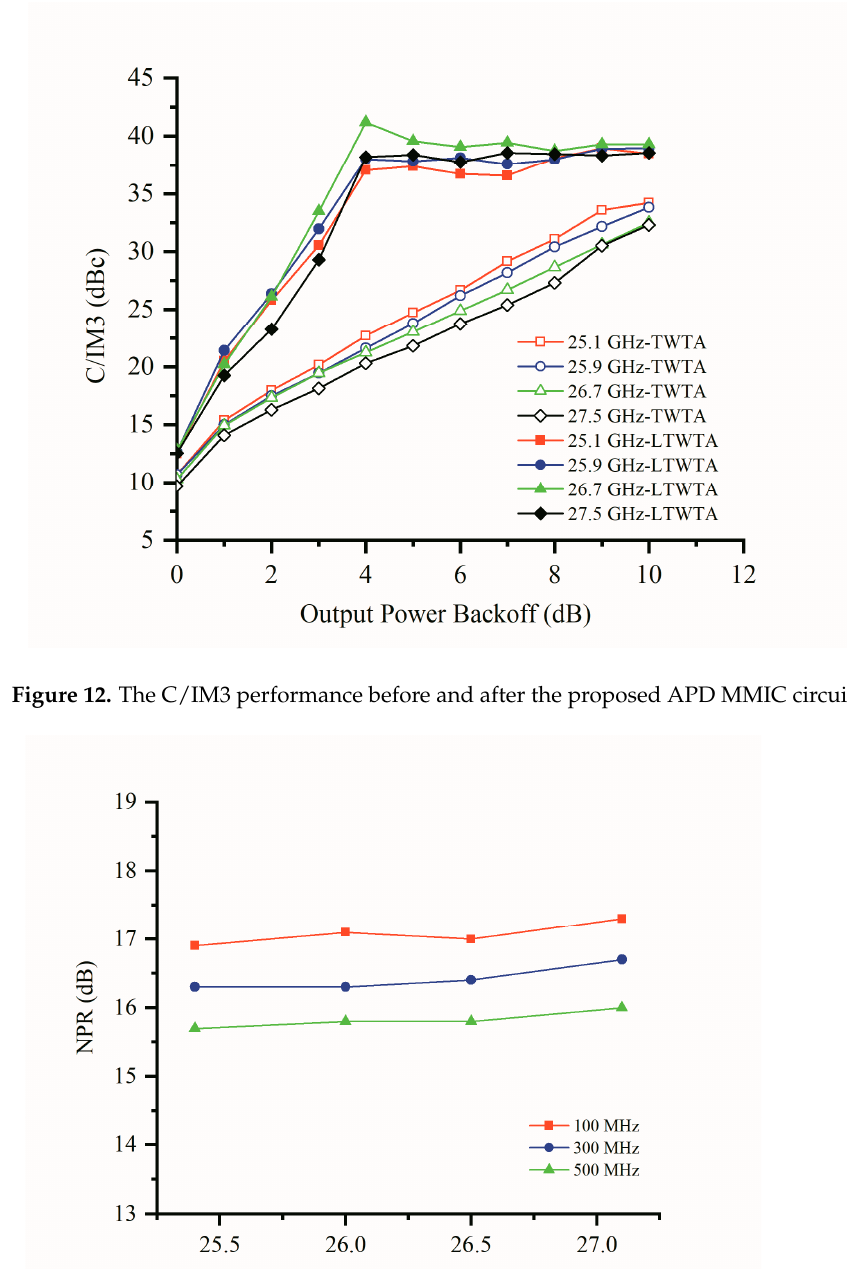
Figure 12. The C/IM3 performance before and after the proposed APD MMIC circuit.